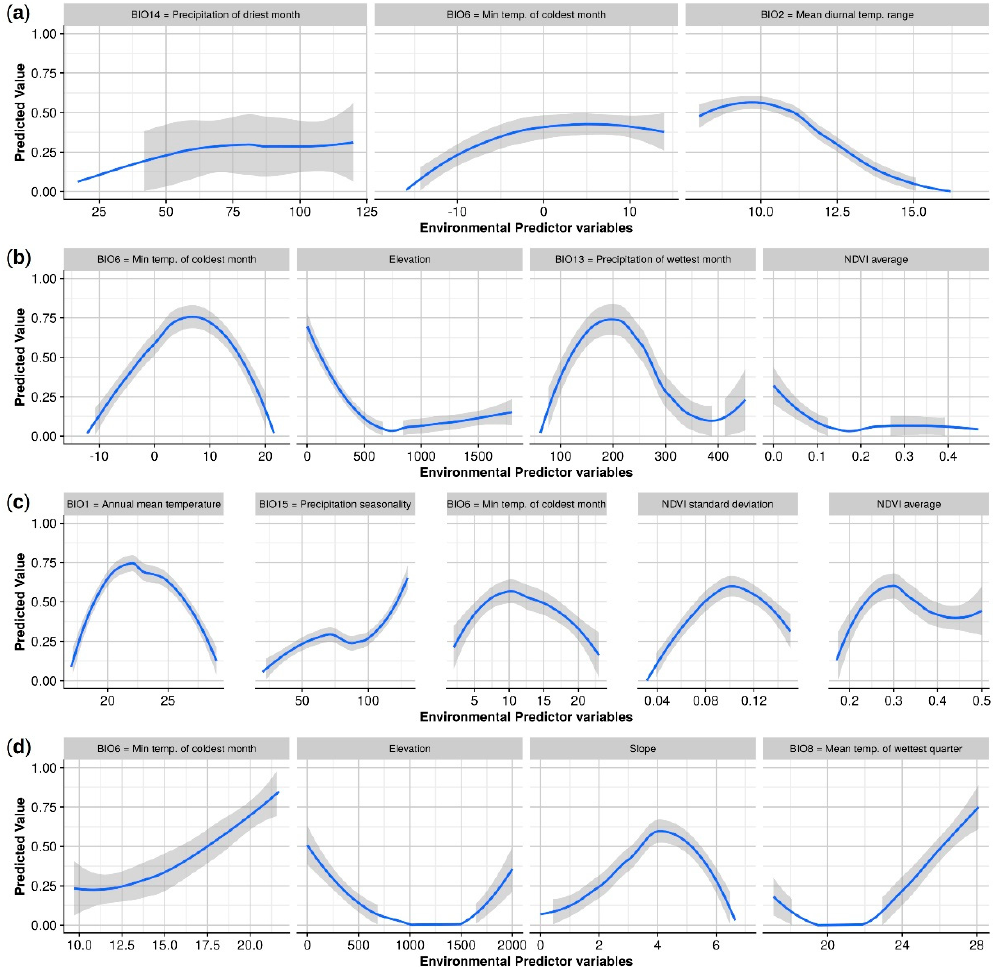
Figure 3. Estimated smoothed trends (using locally estimated scatterplot smoothing (LOESS) with span = 1) and 95% confidence intervals between environmental predictor variables and predicted habitat suitability in MaxEnt models for four exotic Amblyomma species: ( a ) A. americanum ; ( b ) A. maculatum ; ( c ) A. cajennense ; and ( d ) A. mixtum. Trends were derived from the ratio of probability density of each predictor at presence to background geolocations, considering data from 10 iterations used for model training and testing.